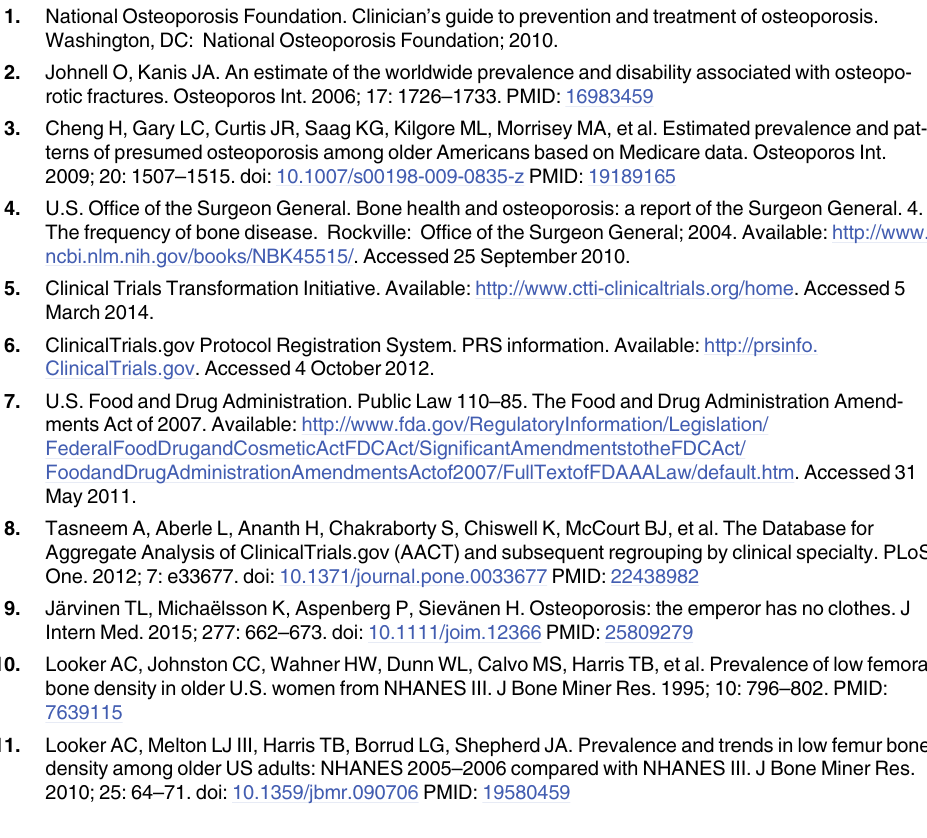
S3 Table. Selected Characteristics of Bone Studies by Gender Restrictions on Enrollment and by Whether Enrollment Was Restricted to